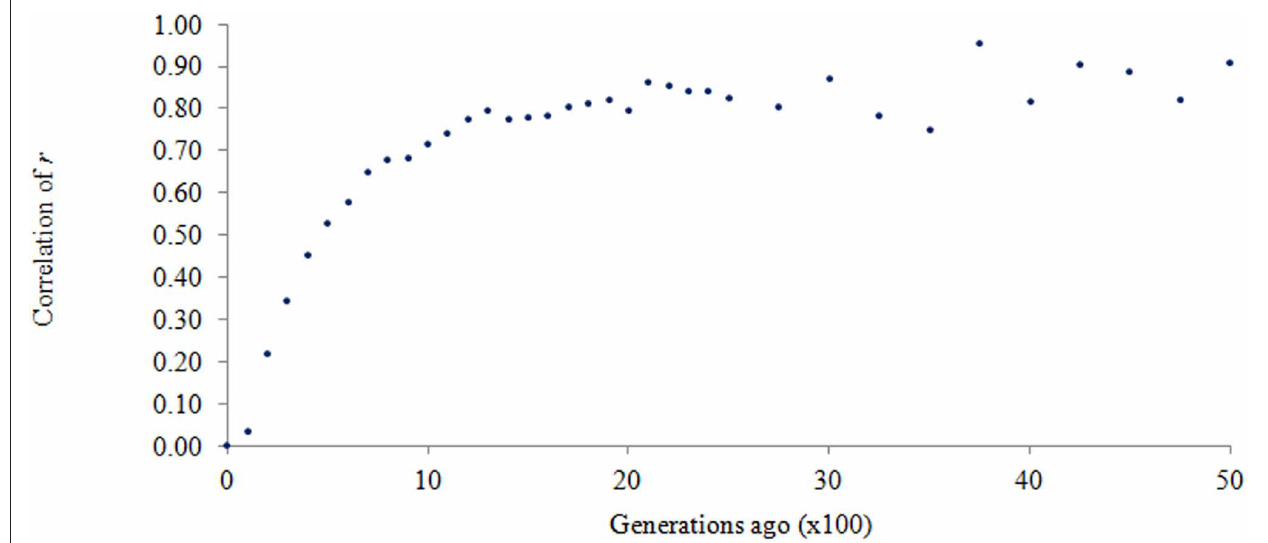
FIGURE 5 | Correlation of r between Angus and Charolais over past